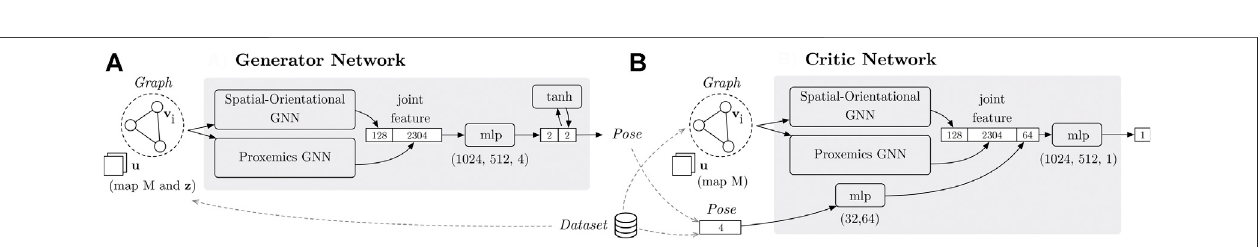
FIGURE 3 | The generator (A) and the critic (B) process the information in the social interaction graph via two GNNs. One GNN reasons about the spatial – orientational arrangement of the group (encoded in the vertex features v i ). The other GNN reasons about proxemics based on the interactant ’ s positions (encodedinthevertices)andthemap(encodedintheglobalattribute u ).Notethattheglobalattributeforthegraphinputtothegeneratoralsoincludesthelatentvariable z . The “ mlp ” blocks are multilayer perceptrons.